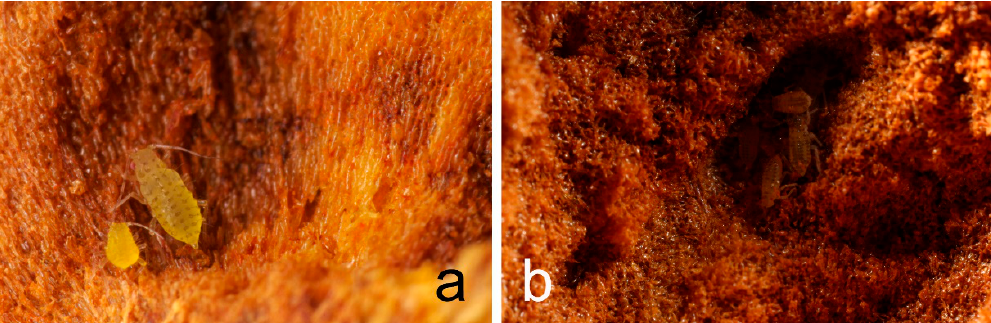
Figure 5. Panaphis juglandis ( a , b ) at different stages of development, still alive and with no signs of damage caused by ants inside a gall nest of C. scutellaris .